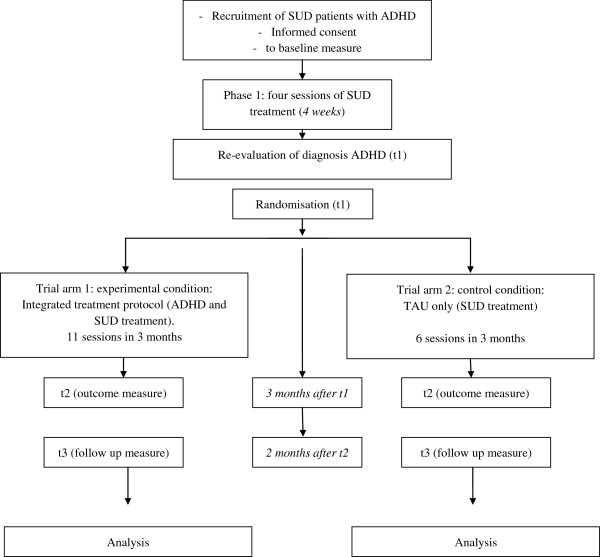
Trial flowchart.